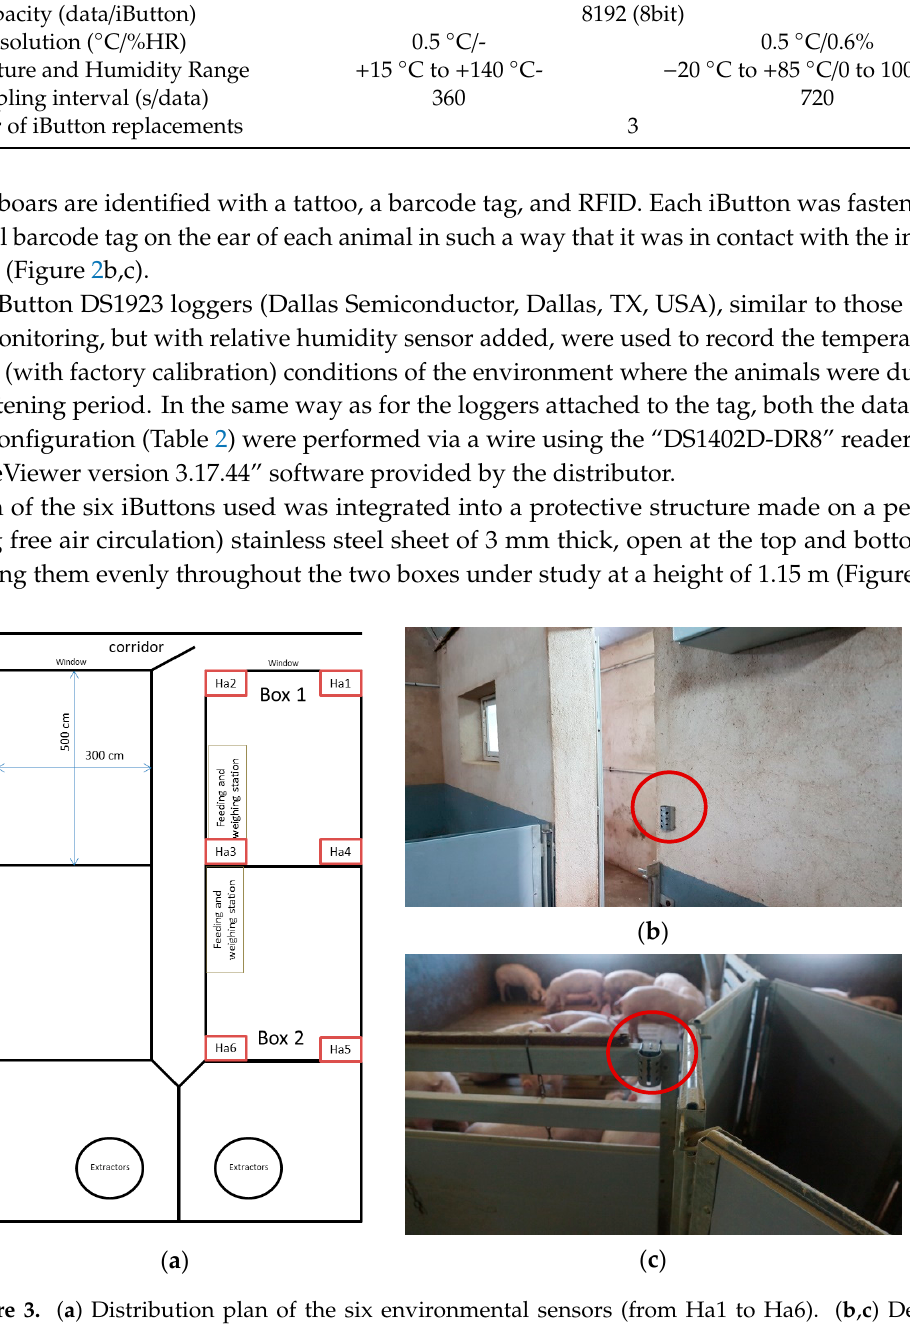
Table 2. Configuration used in the iButton DS1922E & DS1923 loggers.